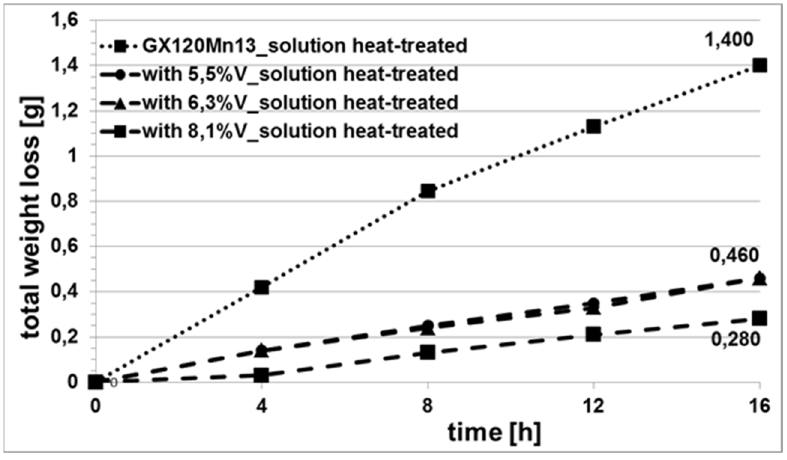
Figure 9. Total weight losses of the tested alloys as a function of abrasion time.